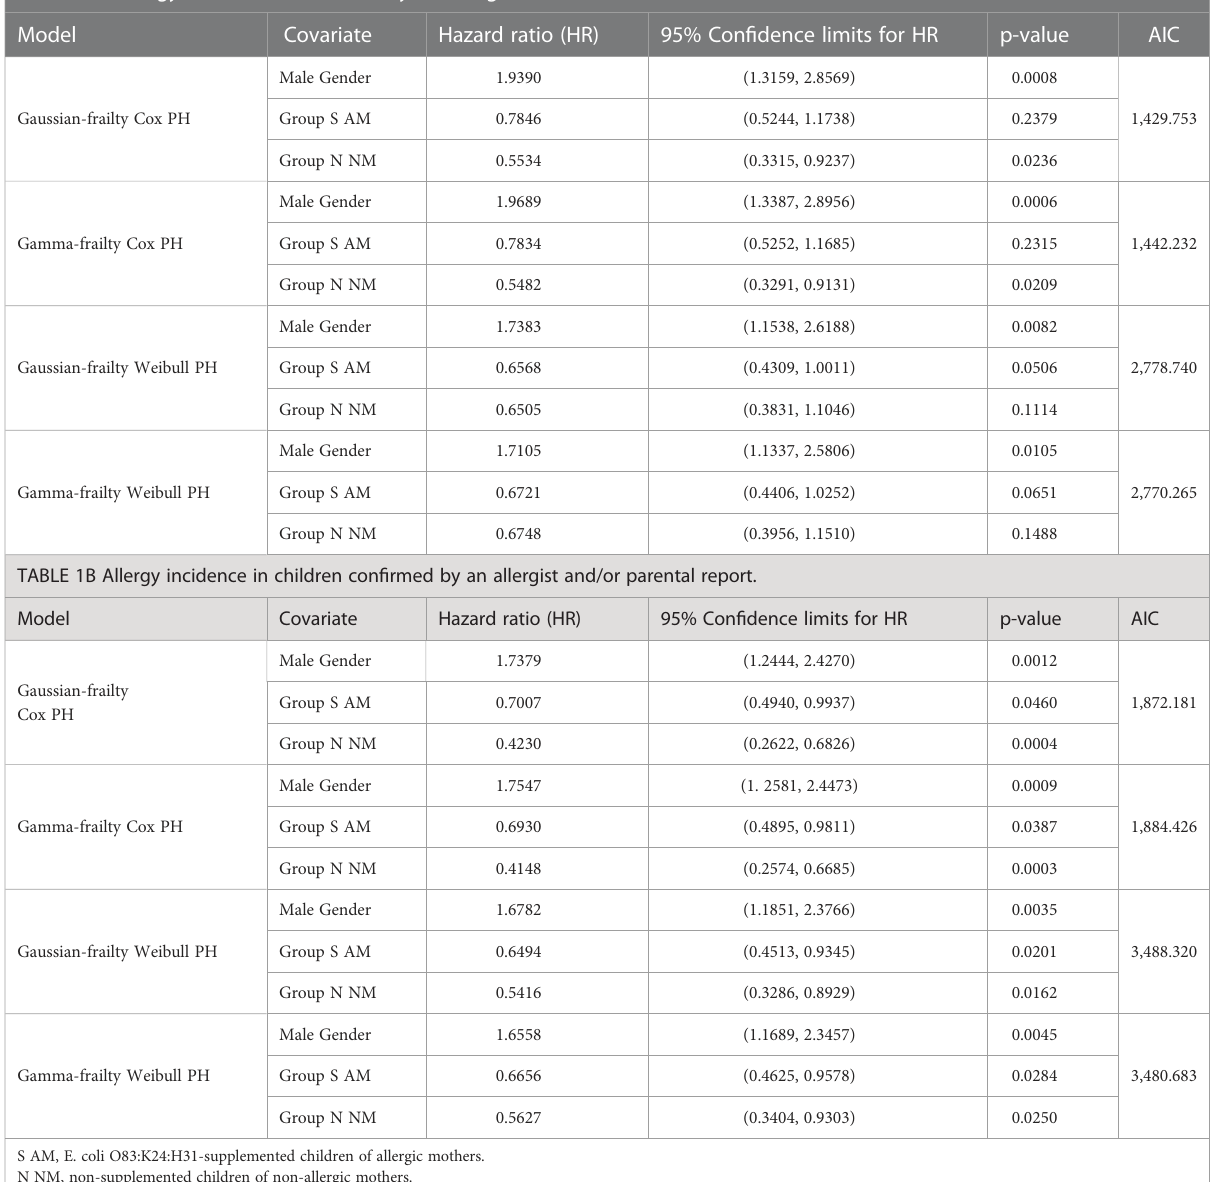
TABLE 1 Allergy incidence in 10-year-old children. TABLE 1A Allergy incidence con fi rmed by an allergist. Model